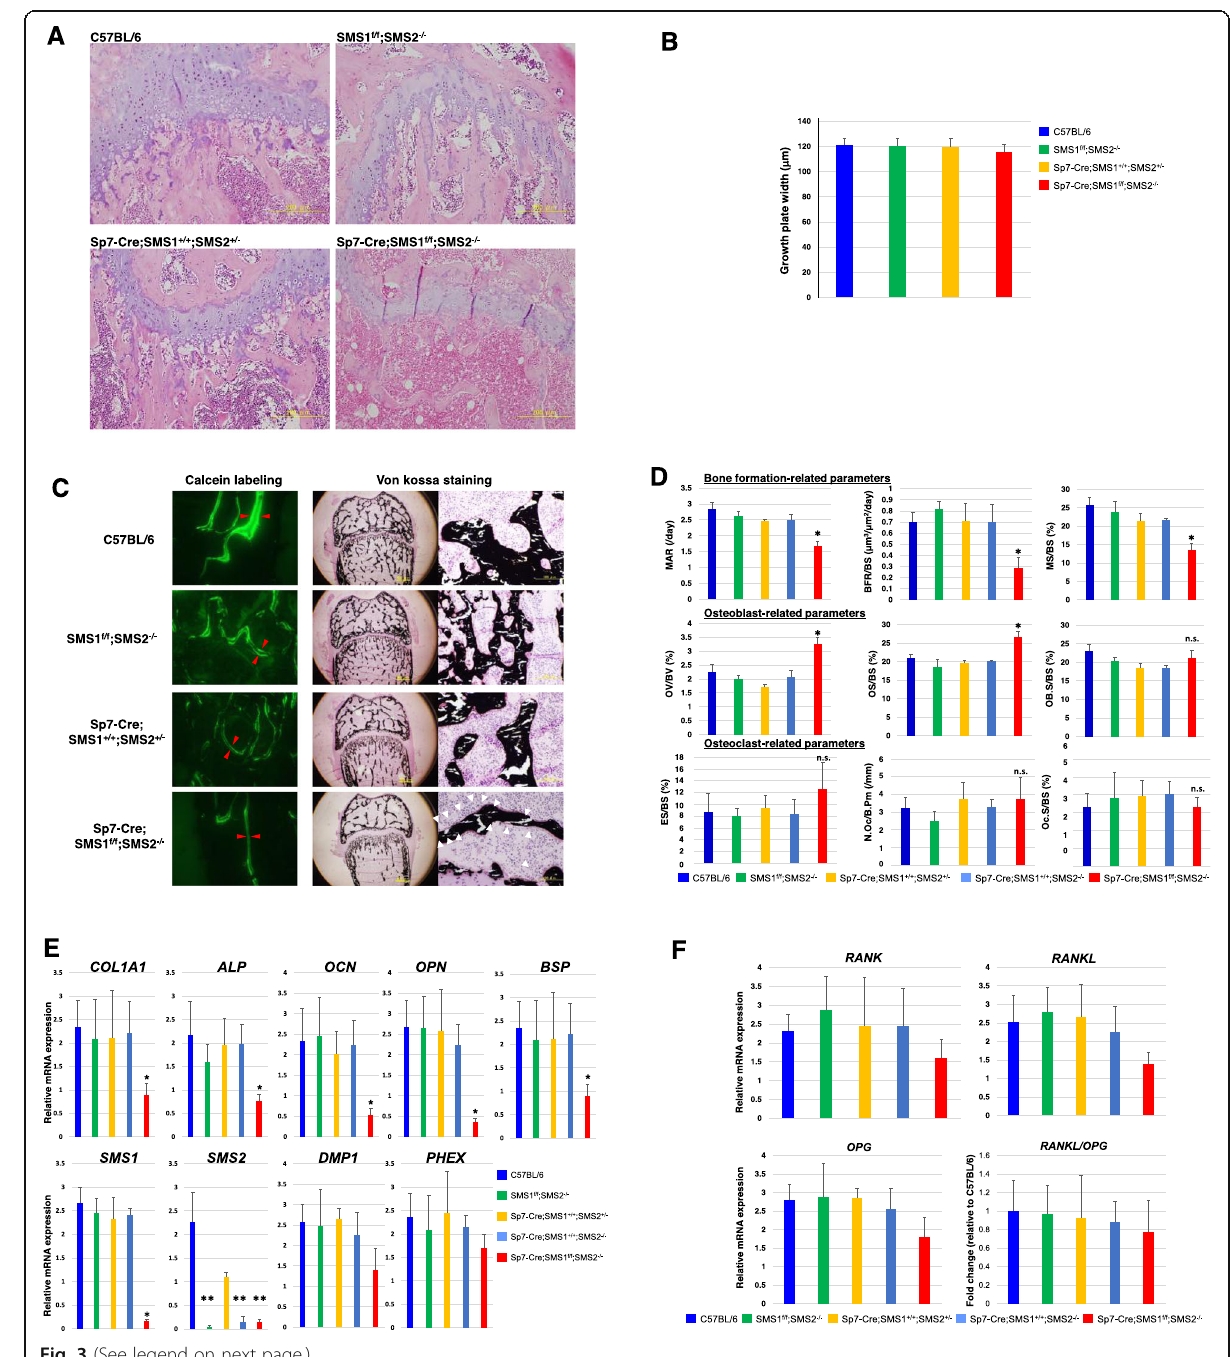
Fig. 3 (See legend on next